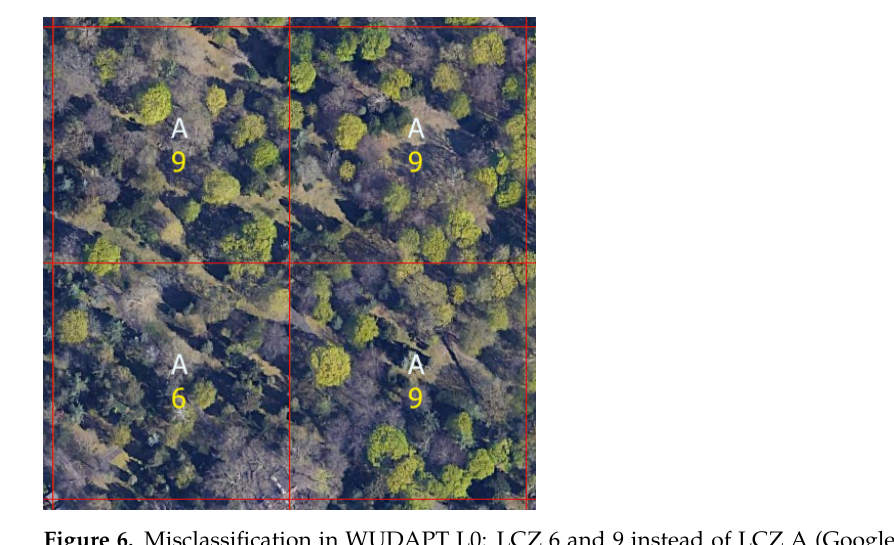
Figure 6. Misclassification in WUDAPT L0: LCZ 6 and 9 instead of LCZ A (Google Earth image in QGIS).